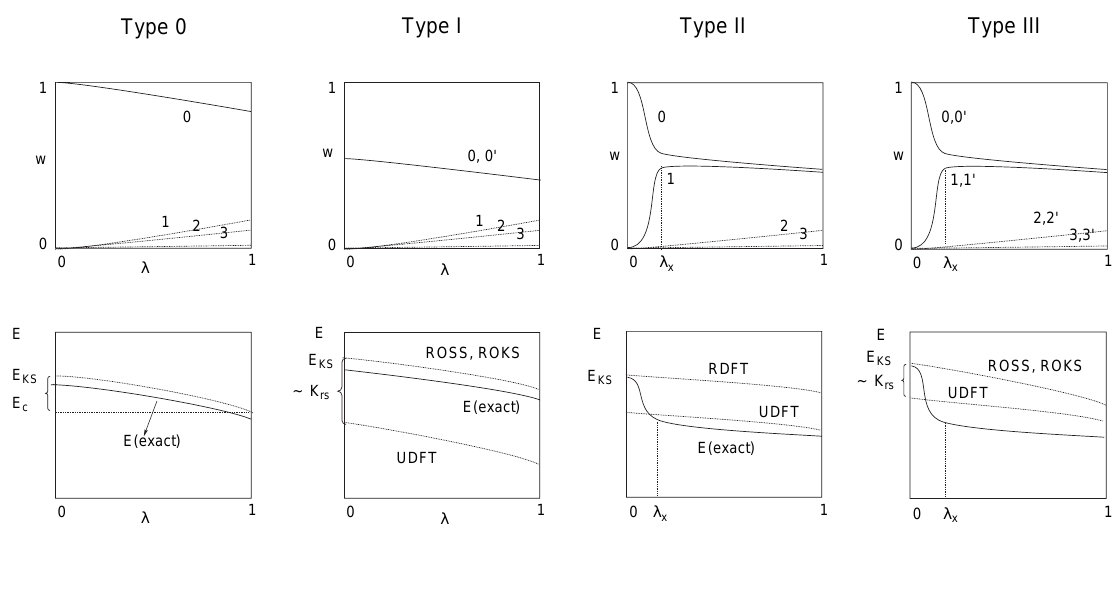
Figure 1: Schematic representation of wave function and energy of type 0, type I, type II, and type III electronic systems as described by RDFT or UDFT with approximate exchange-correlation functionals (dotted lines) or exact Kohn-Sham DFT (solid line). Numbers 0, 1, 2, etc.